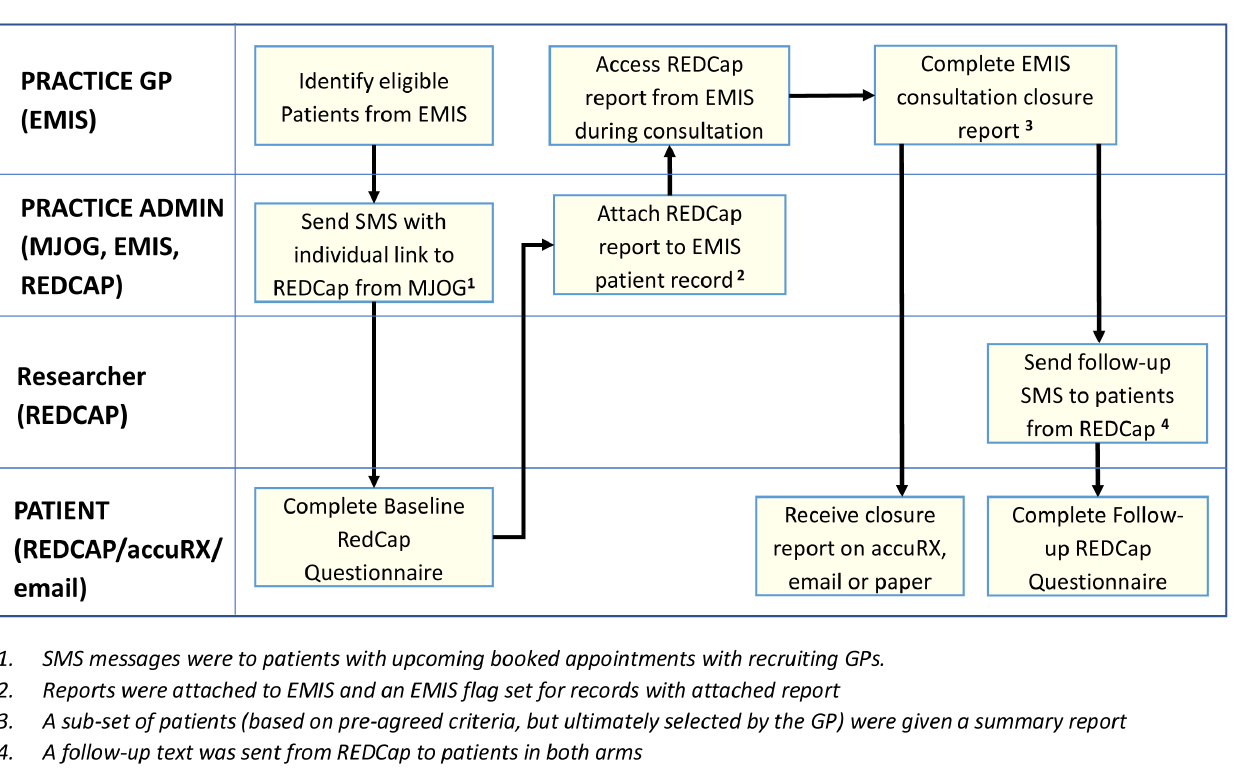
Figure 4. feasibility study workflow: intervention and control